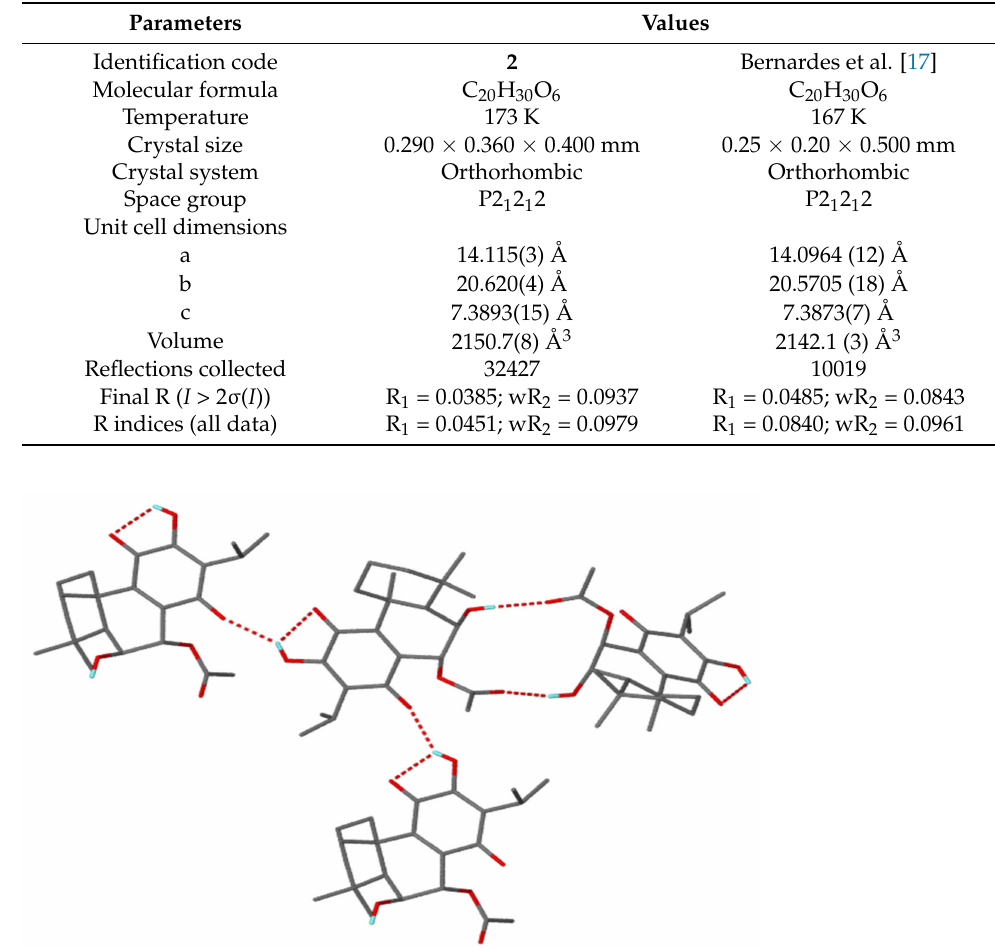
Figure 3. Synthon motif of compound 2